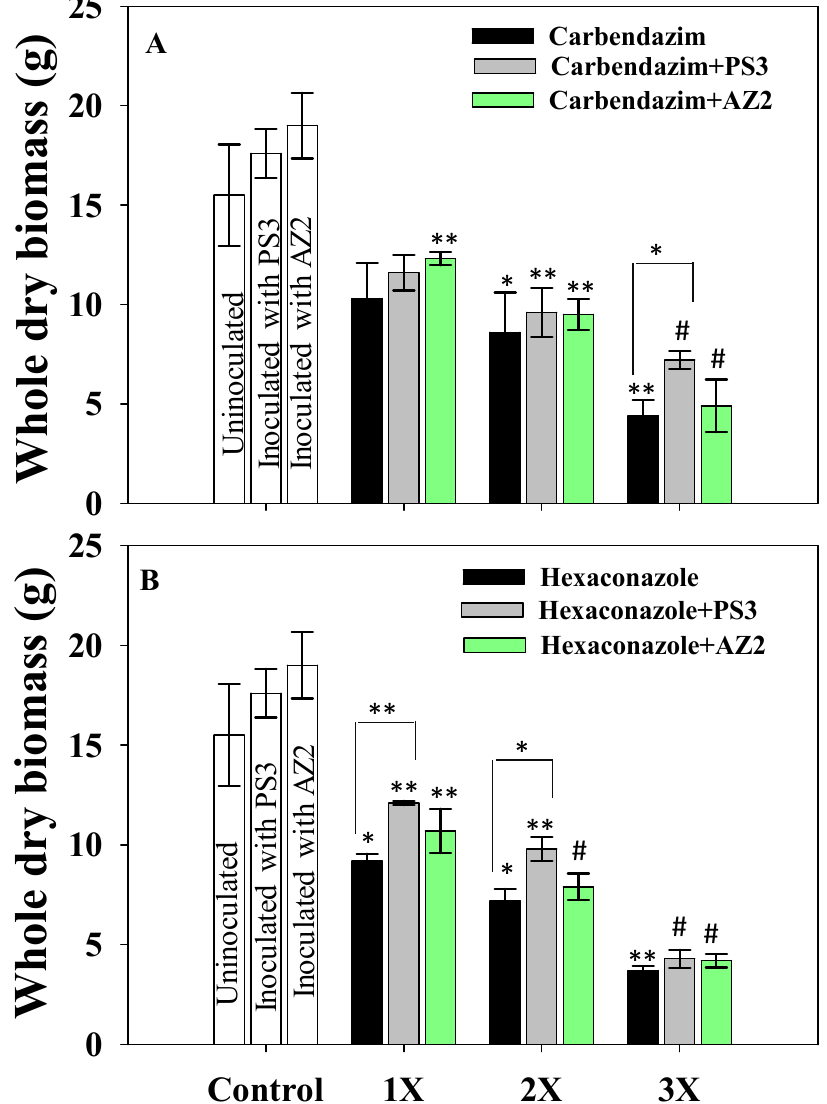
Figure 6. Bio-inoculation effect of Pseudomonas sp. PS3 and Pseudomonas sp. AZ2 on whole dry biomass (g) of R. sativus plants grown in soils treated with varying concentrations of fungicide carbendazim ( A ) and Hexaconazole ( B ). In this figures, histograms represent the mean value of three independent replicates ( n = 3) and error bars represent S.D. The asterisks *, ** and # denote statistical significance at p < 0.05, p < 0.005 and p < 0.001, respectively computed by Student’s t -test. 1X, 2X and 3X denote the normal, two times and three times greater concentrations of fungicide.